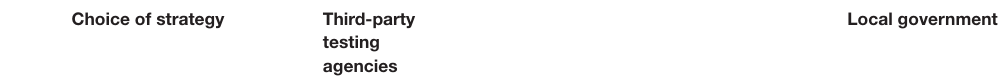
TABLE 2 | Four-party mixed strategy game